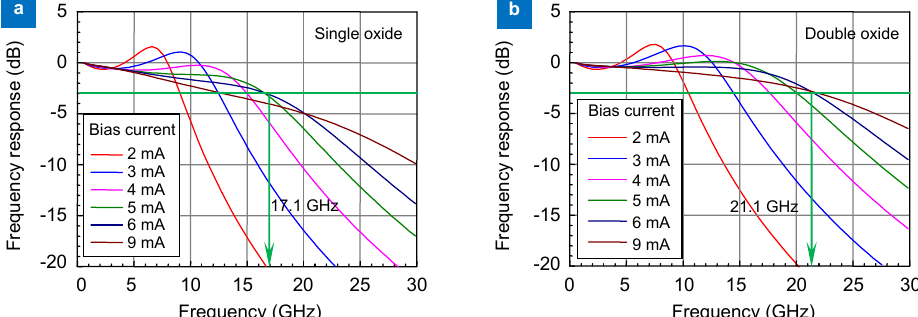
Fig. 3 | Simulated frequency responses of the 850-nm VCSEL with ( a ) single- and ( b ) double-confined oxide layers.